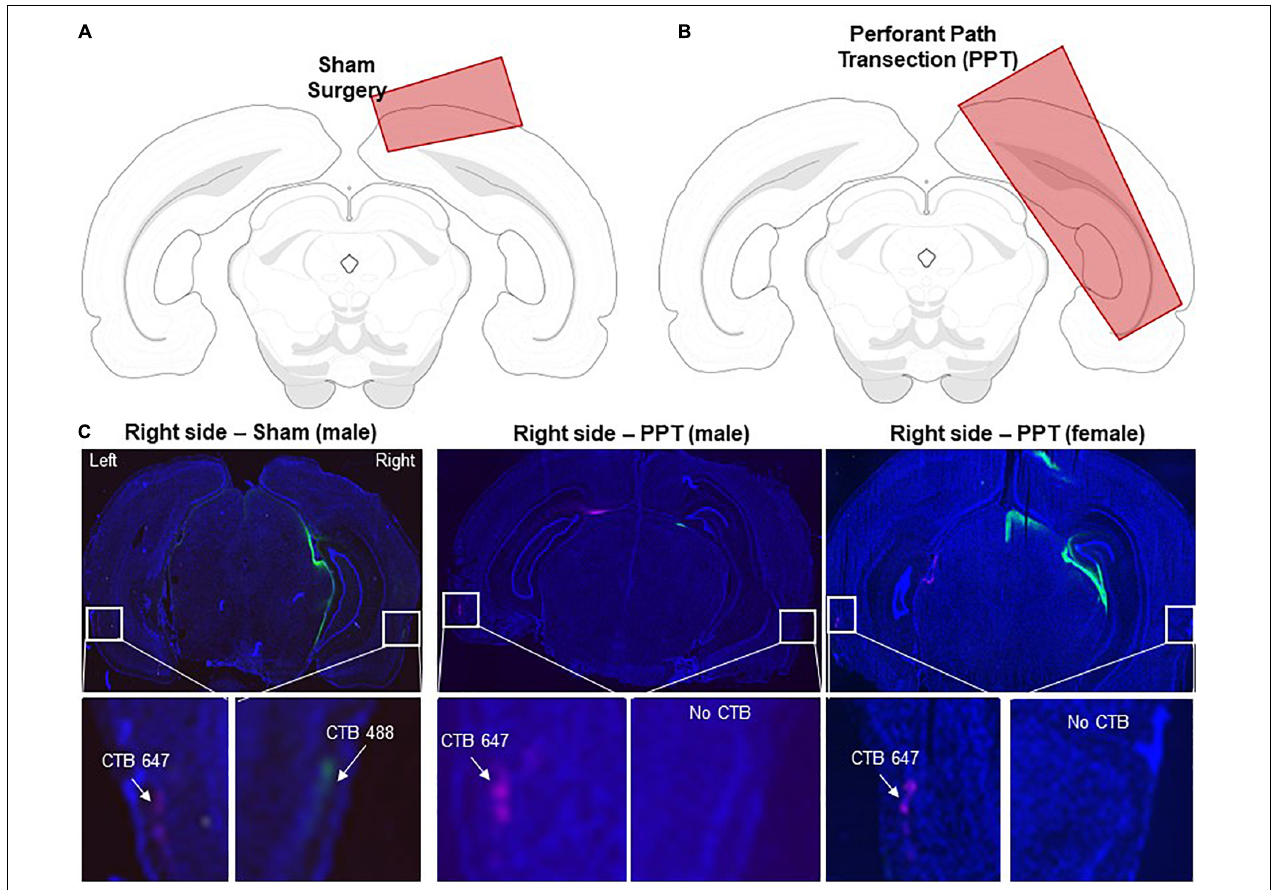
FIGURE 2 | Verification of right hemisphere perforant path transection (Reproduced from Burke et al., 2018). (A) A schematic showing the cortical knife cut in the sham surgical procedures. Note, that the retrosplenial and primary visual cortices were sliced. (B) A schematic showing the cortical knife cut that was used to transect the right perforant path. (C) All rats received injections of the retrograde tracer CTB647 (pink) in the left hippocampus and CTB488 (green) in the right hippocampus. Sham animals had CTB-labeled neurons in the both hemispheres of the lateral entorhinal cortex (left panels). Rats that received the transection (PPT), only had CTB647-labeled cells in the left hemisphere. Nuclei are labeled with DAPI